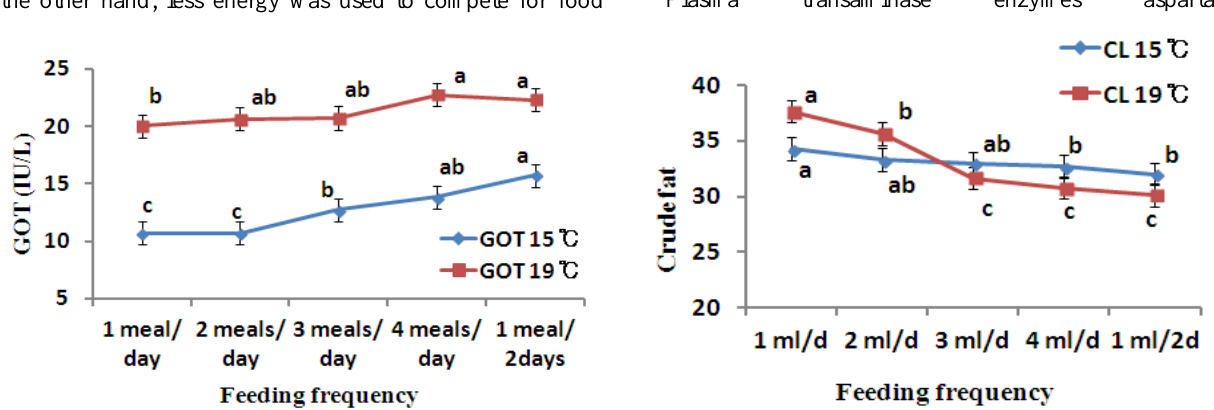
Figure 6. Whole body crude fat of rockfish with different feeding frequencies at 15°C and